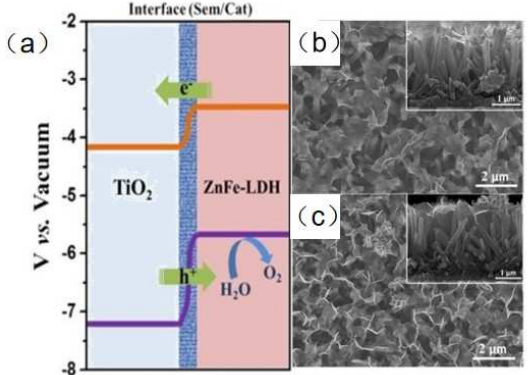
Nanomaterials 2022 , 12 , x FOR PEER REVIEW 10 of 20 Figure 5. ( a ) The band structure of TiO 2 /ZnFe − LDH heterostructure. SEM images of ( b ) TiO 2 /ZnFe − LDH-E and ( c ) TiO 2 /ZnFe − LDH-PE NAs [72]. Copyright 2017 Elsevier. The formation of positive–negative (PN) junctions is a common and effective method to improve photochemical water splitting performance. Yang et al. [77] used NiV-LDH and CdS to form P-N heterojunctions by physically mixing them together in a mass ratio of 1:10 (Figure 6a). The formed NiV-LDH/CdS heterostructure had excellent electron-hole separation ability, and the hydrogen evolution efficiency is significantly greater than that of pure NiV-LDH and CdS (Figure 6b). Sahoo et al. [78] constructed a heterojunction be- tween Co(OH) 2 and ZnCr-LDH by an ultrasonication method. The H 2 and O 2 evolution apparent conversion of optimized Co(OH) 2 -modified ZnCr LDH sample reached 13.12% and 6.25% in 2 h, respectively. Figure 6. ( a ) The synthesis process of NiV-LDH/CdS. ( b ) The amount of hydrogen produced by CdS, NiV-LDH, and CNV-2. Copyright 2021 Elsevier [77].